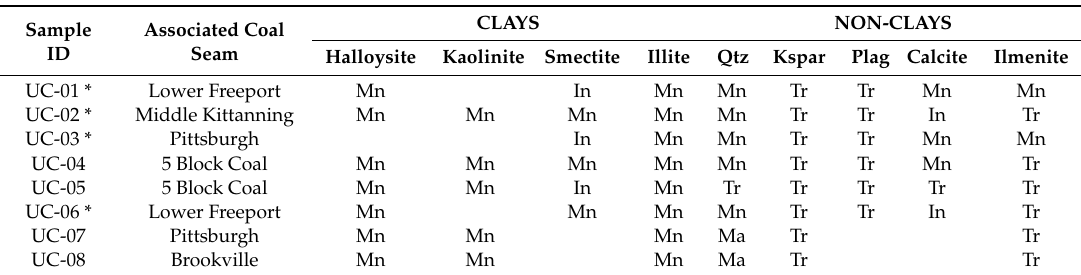
Table 4. Semi-quantitative XRD results: Major (Ma) ( > 50%)-Intermediate (In) (25–50%) Minor (Mn) (5–25%)-Trace (Tr) ( < 5%). Qtz = quartz, Kspar = potassium (K) feldspar, Plag = plagioclase (Ca / Na) feldspar.